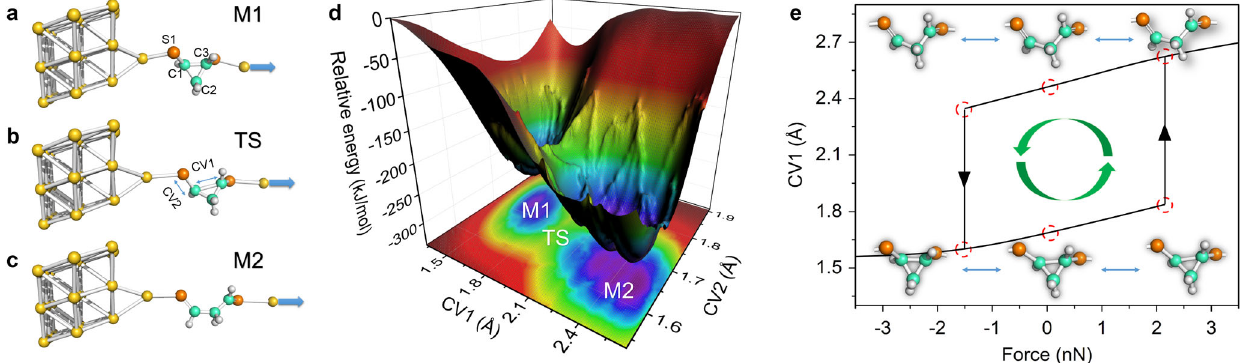
Fig. 2 Force-induced ring-opening and ring-closure reactions. The snapshots of Au/CPDT/Au junction ring-opening process are: local minimum M1 a ; transition state TS b ; local minimum M2 c . Au, yellow ; S, orange ; C, green ; H, gray (rendered in PyMOL). d The FES for CV1-CV2. CV1 is the collective variable for the distance of C1 – C3; CV2 is the collective variable for the distance of C1 – S1. e The structural hysteresis under mechanical load extracted from force transformed FES (see Fig. S5). The arrows show the directions of conformational